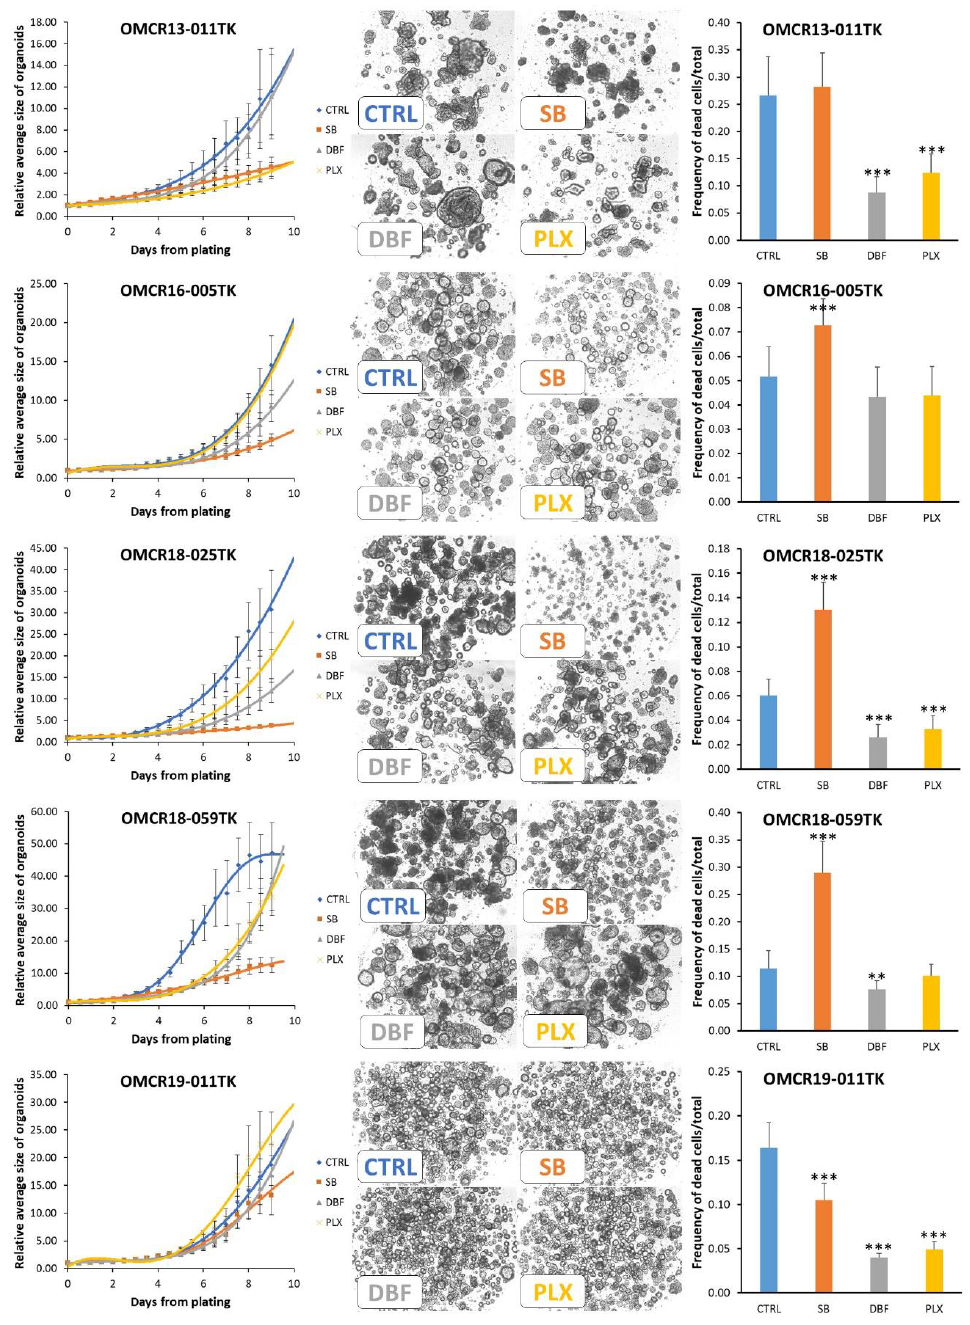
Figure 4. Modulation of BRAF-mutated organoid growth by SB202190 (10 µ M), Dabrafenib (1 µ M) and PLX8394 (1 µ M). Left column: interpolation of the growth curves live-monitored for 9 days (12 h steps); all data are normalized against point 0 values to reduce variations in plating efficiency among different organoids. Each experimental point represents the mean of 4 – 5 replicates (geltrex domes) in three tests. Mutations: OMCR13-011TK BRAF K601E; OMCR16-005TK and OMCR18- 025TK BRAF V600E; OMCR18-059TK BRAF Val471dup; OMCR19-011TK BRAF G469V. The statistics of each experimental point vs. controls (CTRL) are detailed in TabS3. Center column: example images from the last experimental point; the organoids monitored in a single geltrex dome are shown. Right column: the cytotoxic effects of drugs were assessed using live fluorescent marking and normalized against total cells (in the same tests shown in the left column). Statistics vs. controls (CTRL): ** p ≤ 0.01; *** p ≤